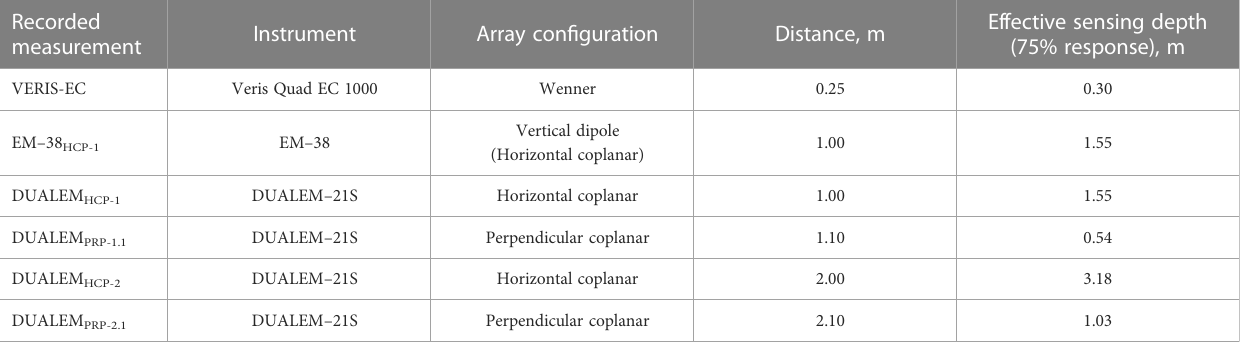
TABLE 2 List of recorded